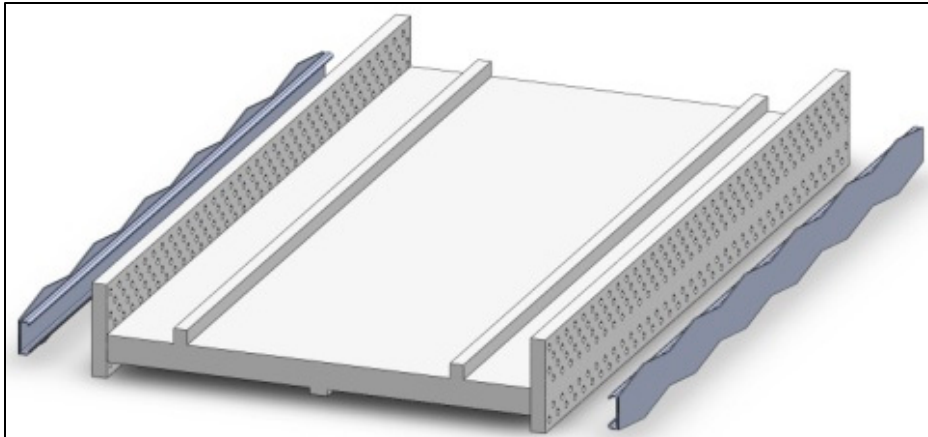
Figure 12. General view of model with devices.